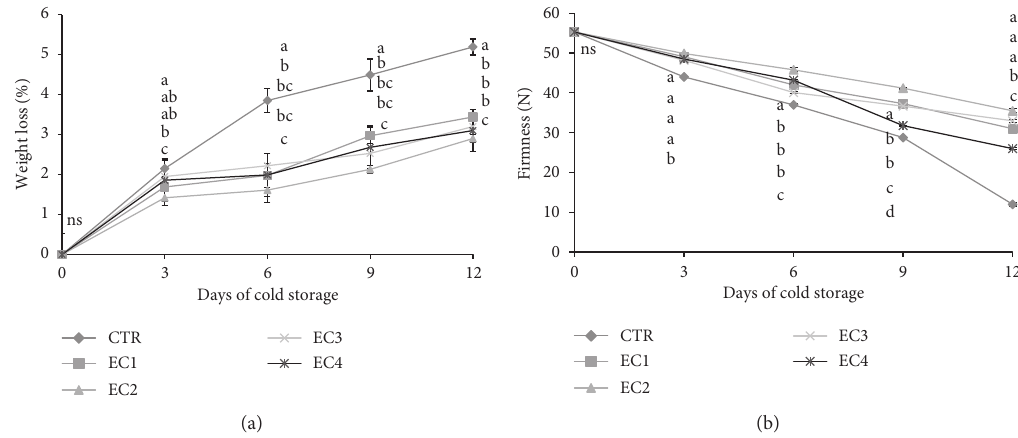
Figure 1: Trend of weight loss (%) and firmness ( N ) of fresh-cut papaya fruit cold stored and treated with edible coating. Values were recorded at 0, 3, 6, 9, and 12 days at 5 ° C and RH 90%. Significant values are indicated with equal letters in each